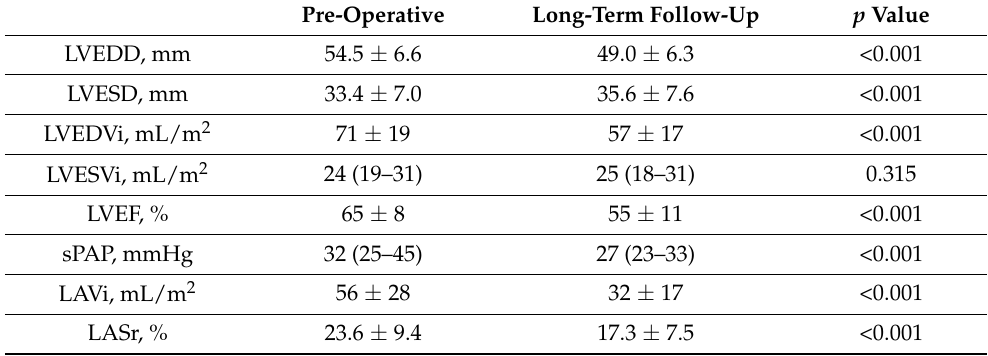
Table 2. Changes in echocardiographic variables at long-term follow-up after mitral valve repair.